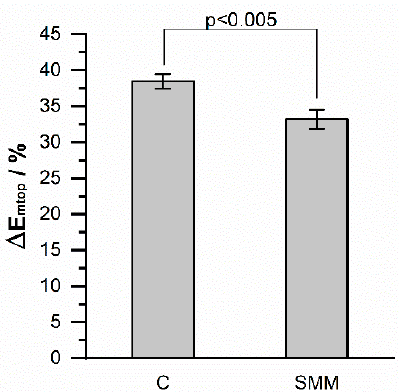
Figure 9. Comparative graph of the ∆ E mtop of the biosensor response to di ff erent DNA sequences. Complementary DNA (C) and single-base mismatch (SMM).